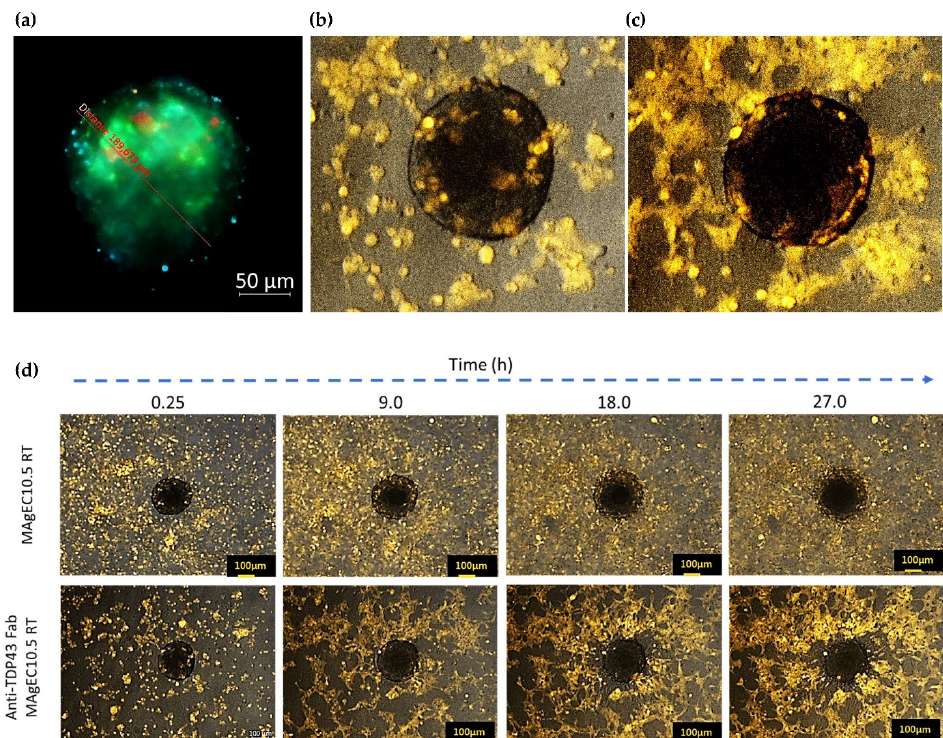
Figure 5. Brain spheroid mediated preferential recruitment of the MAgEC 10.5 RT cells and the Fab-producing MAgEC RT clones. ( a ) Brain spheroid formation and cell identification by fluorescence microscopy. Each cell type is differently labeled: Pericytes-like cells in blue (Hoechst), MBr MEC.FVB in green (DiO), astrocytes in red (DiD). Herein, at day 2. ( b ) Recruitment of the anti-TDP-43 MAgEC 10.5 RT to brain spheroid model. The red fluorescent anti-TDP-43 MAgEC 10.5 RT are detected after 3 h in the spheroids and individually. ( c ) After 30 h the anti-TDP-43 MAgEC 10.5 RT penetrate the brain spheroids, form pseudo vessels and rearrange on the superficial endothelial part of the spheroids. ( d ) Time-related recruitment of the MAgEC10.5 RT cells and the anti-TDP-43 MAgEC RT cells towards the BBB from brain spheroids showing the fast and comparable recruitment of the endothelial progenitors before and after transfection, their pseudo tube formation penetration and selective organization in the brain spheroids.